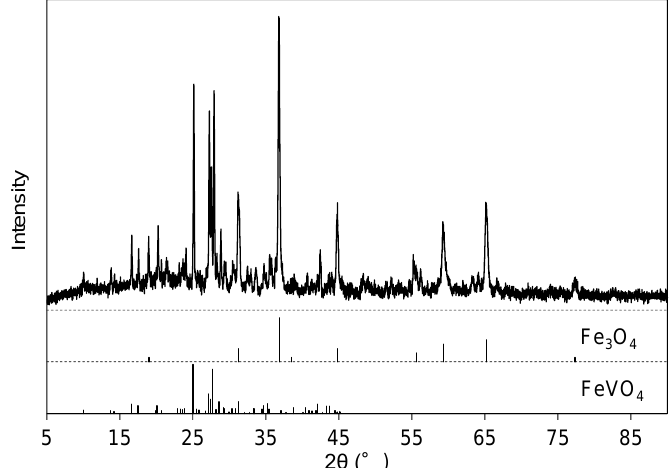
Figure 4. X-ray diffraction (XRD) pattern of Precipitate A after the heat treatment at 700 °C. The line diagram below the pattern indicates the peak positions of Fe 3 O 4 (ICDD #26-1136) and FeVO 4 (ICDD #38-1372).